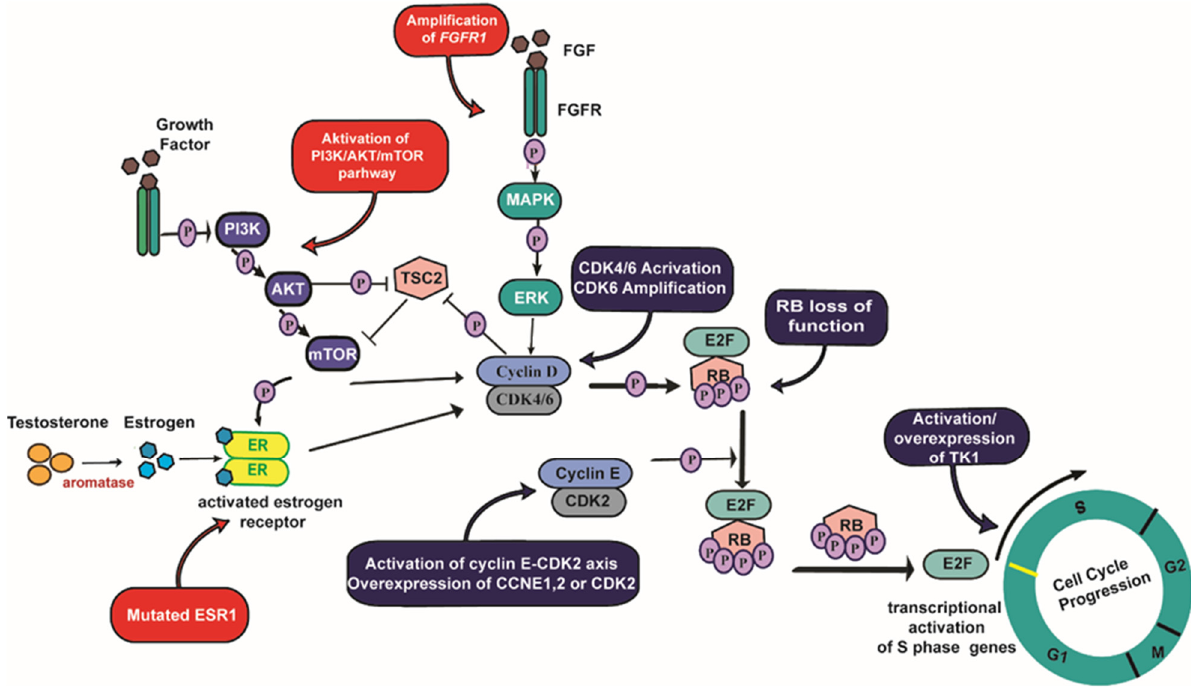
Figure 1. Key mechanisms implicated in the development of resistance to combined CDK4/6i and ET. Cell cycle-specific components are indicated in blue and activation of oncogenic pathways are indicated in red.